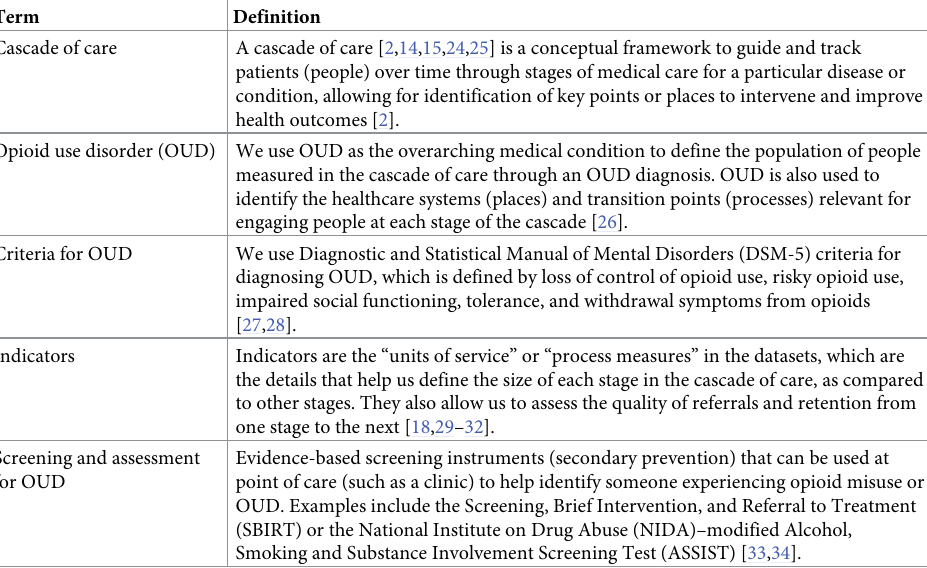
Table 1. Glossary of terms guiding the framework development